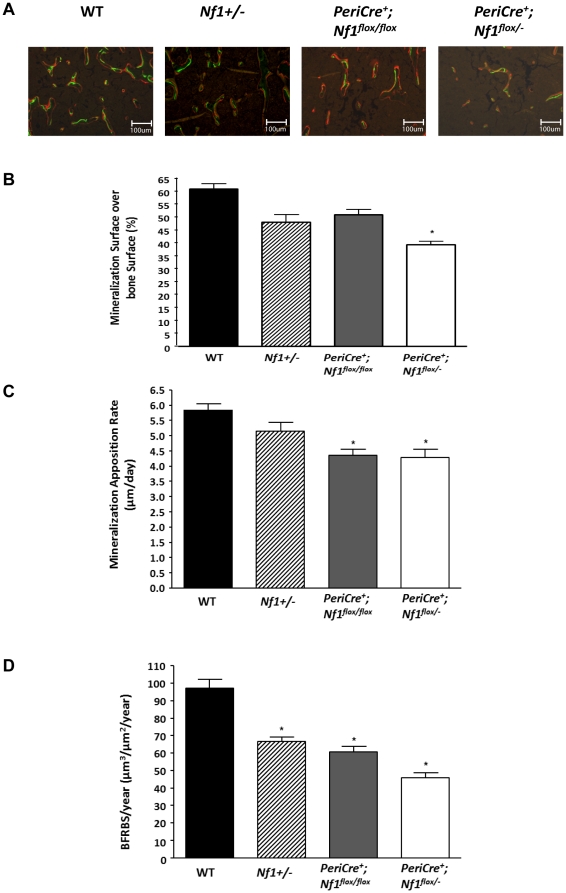
Loss of Nf1 results in reduced bone turnover in vivo.(A) Representative photomicrographs showing the uptake of calcein and alizarin fluorochromes into newly mineralizing bone. (B) Quantification of the proportion of the total trabecular surface that was actively engaged in bone mineralization (MS/BS). (C) The radial rate of bone deposition at active sites (MAR) is shown. (D) The total rate of newly forming bone (BFRBS/year) was calculated and shown.